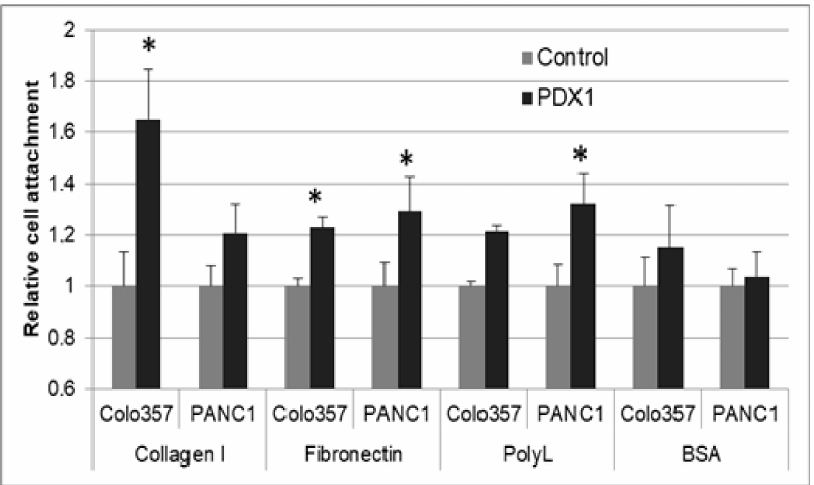
Figure 6. PDX1 gene expression increases cell adhesion. A quantitation of adhesion and cell attachment by cell binding to collagen type I, fibronectin, poly-L-lysine, and BSA (as a control). Data are given as the mean cell attachment ± SEM ( n = 3). * p <